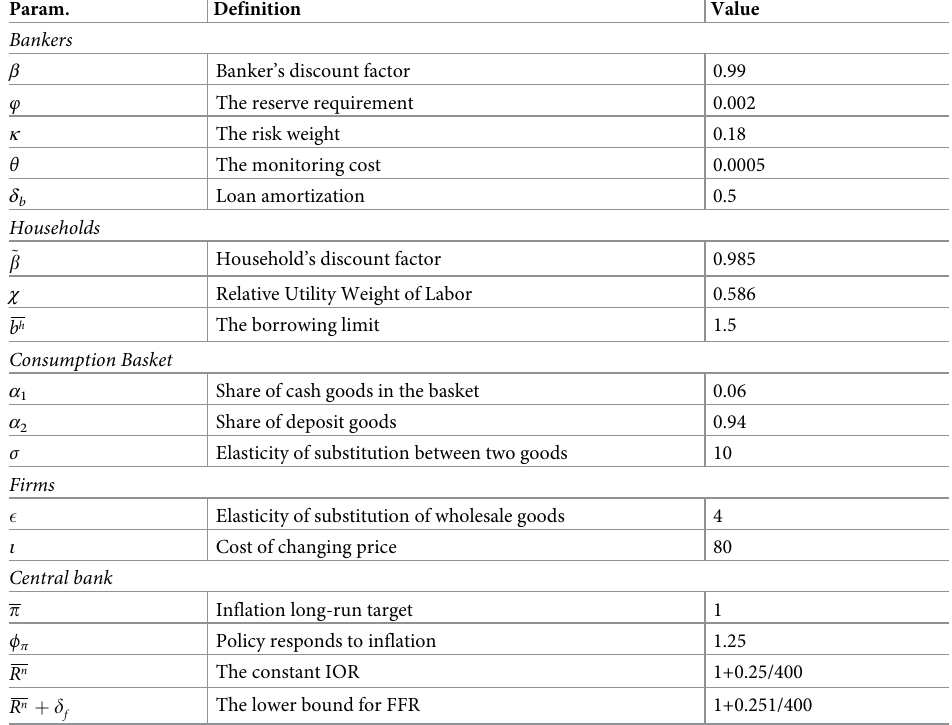
Table 7. Parameter values.